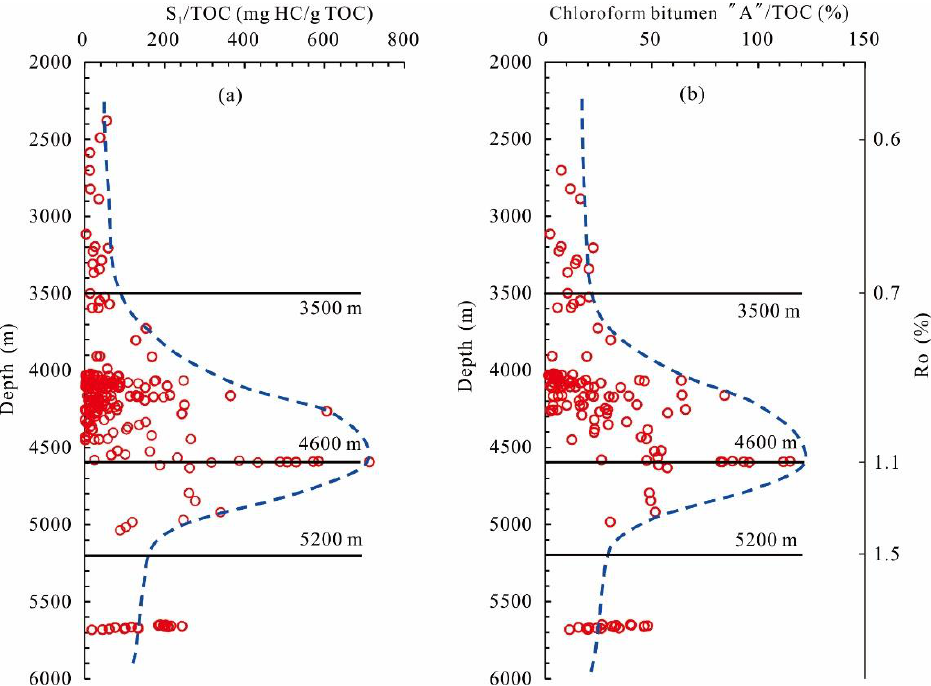
Figure 10. Relationship between hydrocarbon generation conversion rate and burial depth of source rocks in the Fengcheng Formation, Mahu Sag. ( a ) S 1 /TOC varies with depth and Ro to determine the main oil generation stage. ( b ) Chloroform bitumen “A”/TOC varies with depth and Ro to determine the main oil generation stage.